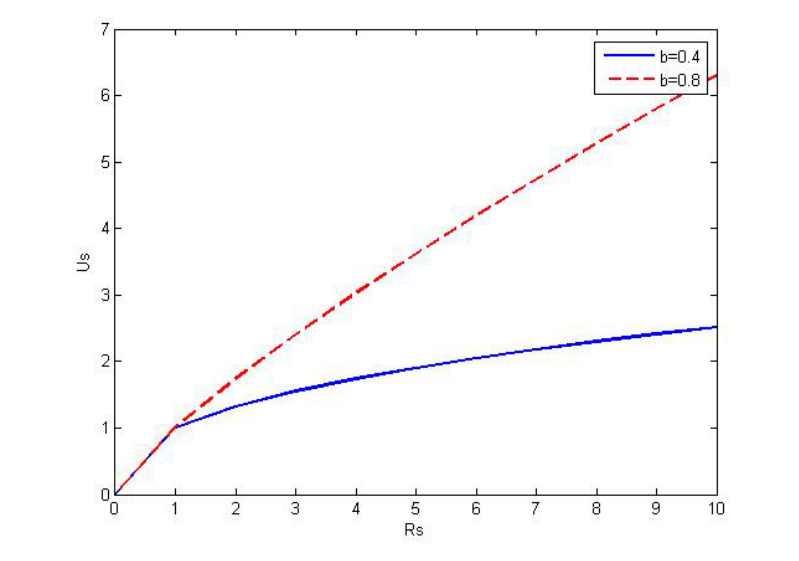
Figure 4. The satisfactory function of secondary user versus data rate R s